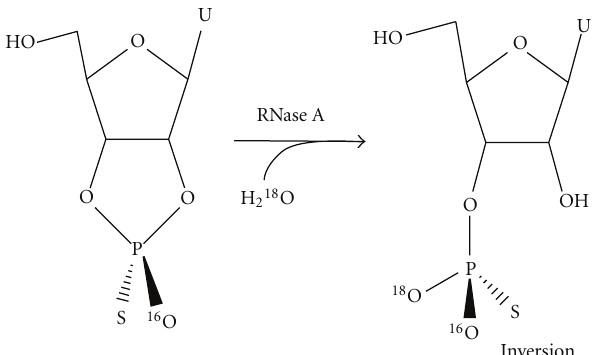
Figure 6: Stereochemistry of the reaction catalyzed by RNase A [10]. The intermediary 2 (cid:2) ,3 (cid:2) cyclic nucleotide (cNp or cNMP) is hydrolyzed to a 3 (cid:2) phosphorylated mononucleotide. Other 2 (cid:2) -OH requiring enzymatic and alkaline hydrolysis may go through the same